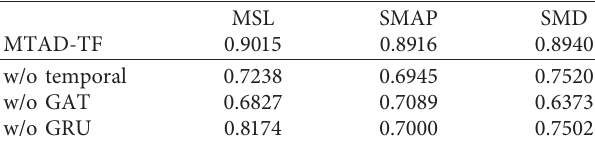
Table 3: Ablation study. F1 scores are